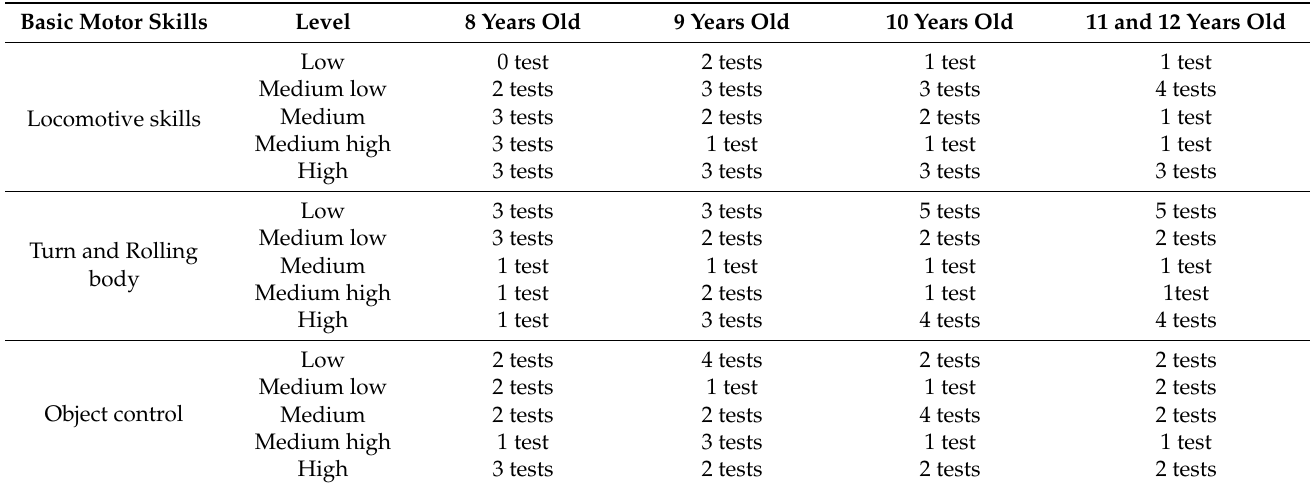
Table 2. Distribution of the evaluated motor tasks by